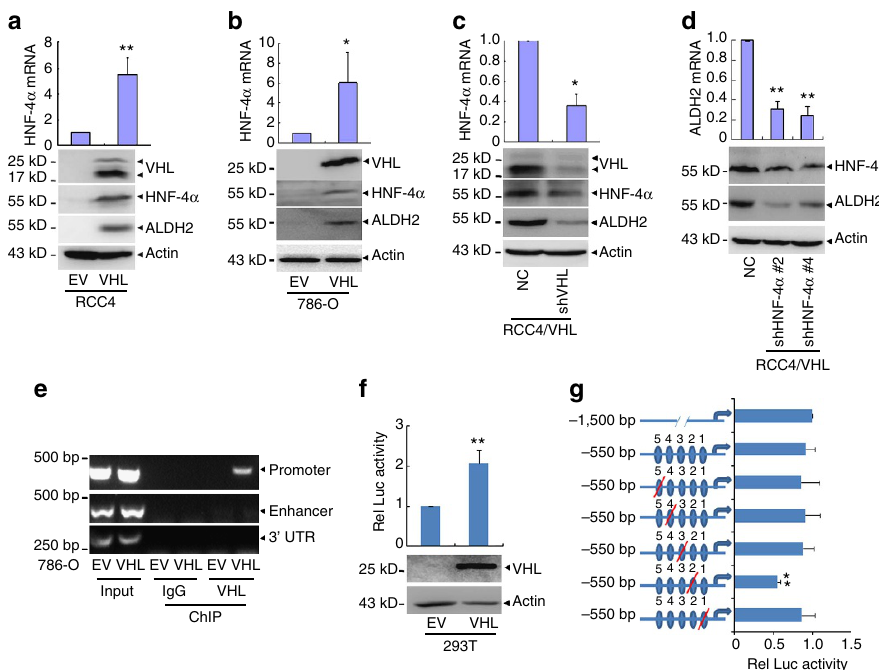
Figure 7 | VHL regulates ALDH2 expression through HNF-4 a . ( a – c ) The mRNA and protein levels of the indicated genes were detected by real-time quantitative PCR with reverse transcription (RT–PCR) and Western blot respectively. ( d ) RCC4/VHL cells were stably transfected with shRNAs against HNF-4 a (#2 and #4), the mRNA and protein levels of the indicated genes were detected. ( e ) VHL binding to HNF-4 a promoter or enhancer was analysed by chromatin immunoprecipitation in 786-O/EVand 786-O/VHL cells. Chromatin was immunoprecipitated with IgG or anti-VHL antibody and analysed by PCR using primers indicated above. ( f ) 293Tcells were transfected with luciferase reporter plasmids driven by HNF-4 a promoter together with or without VHL expression vector for 36h, then detected the relative luciferase activity. Protein levels of VHL were detected by western blot with actin as a loading control (low panel). ( g ) Luciferase reporter plasmids driven by trunk or mutated sequences as indicated were transfected together with VHL-expressing vector or empty vector into 293Tcells for 36h. All the relative luciferase activities of HNF-4 a promoter were normalized by pSV40-Renilla and estimated as the relative folds against cells. Blue ovals represent potential-binding sites. Arrows represent the transcriptional start point of HNF-4 a . Columns, means of three independent experiments; bars, s.d. (* P o 0.05,** P o 0.01 for t